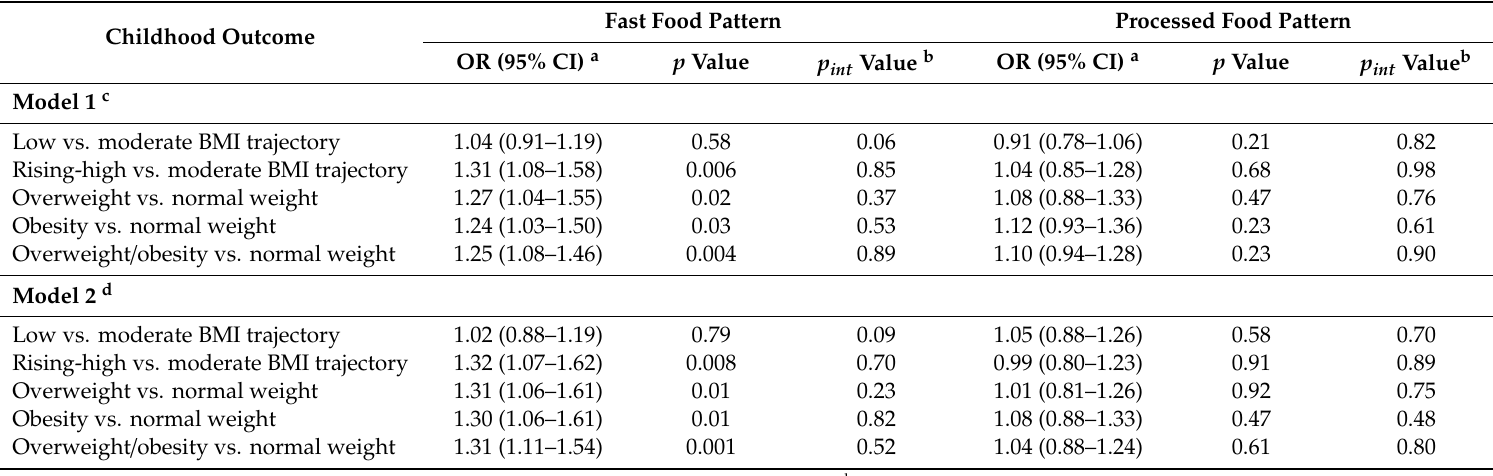
Table 3. Associations between maternal fast food pattern and processed food pattern scores during pregnancy and children’s growth trajectories and overweight / obesity risk at age